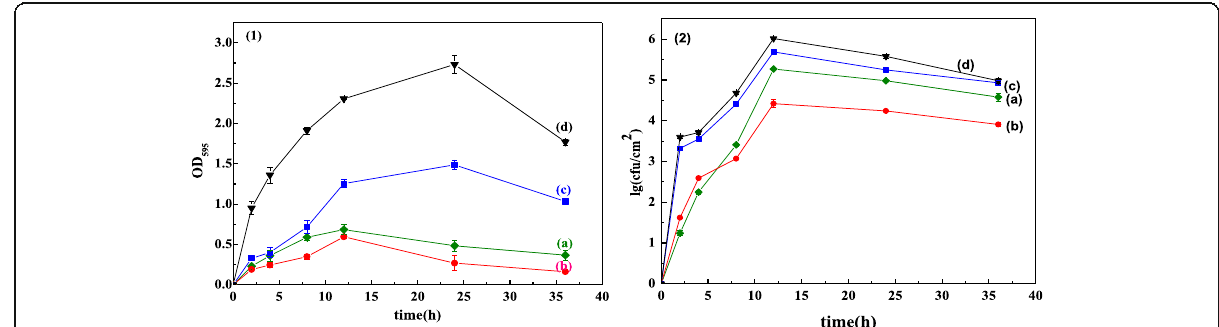
Fig. 7 The adhesion of Shewanella putrefaciens biofilm ( 1 ) and colony growth curve of the biofilm bacteria ( 2 ) on the ZnO films prepared on PAA with different time of two-step anodization duration (a) 0 min, (b) 40 min, (c) 60 min, and (d) 80